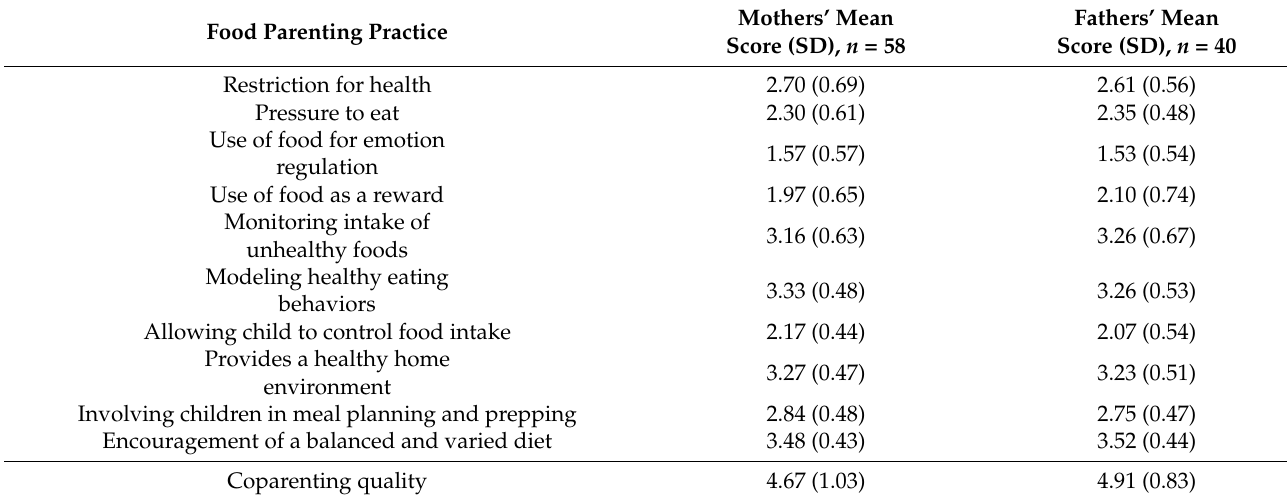
Table 2. Mean scores on the comprehensive food parenting practices questionnaire and the coparenting quality questionnaire among mothers and